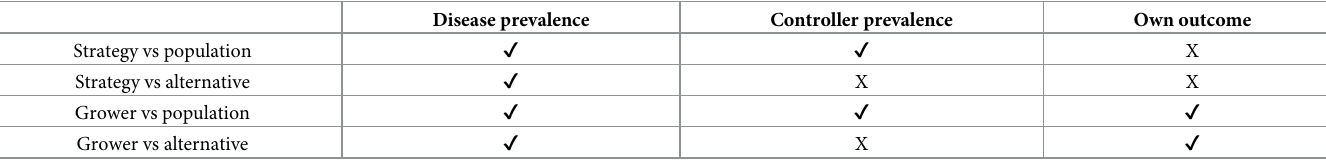
Table 2. Summary of the information required by growers to carry out each means of comparison. “Controller prevalence” refers to the proportion of growers that ) and “disease prevalence” is the proportion of growers that are currently infected (i.e. I N þ I C adopted control the last time their field was planted (i.e. S C þ I C N when information is required, and “X” when it is not necessary for decision-making.